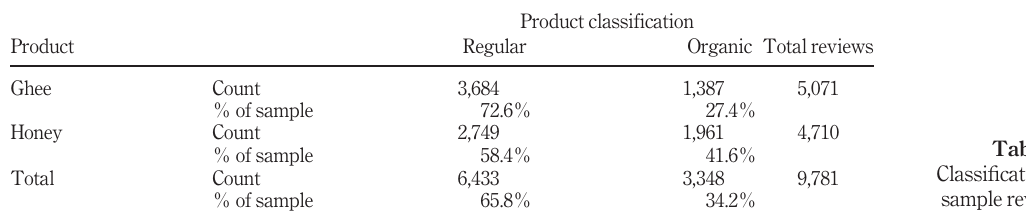
Table 1. Classi fi cation of